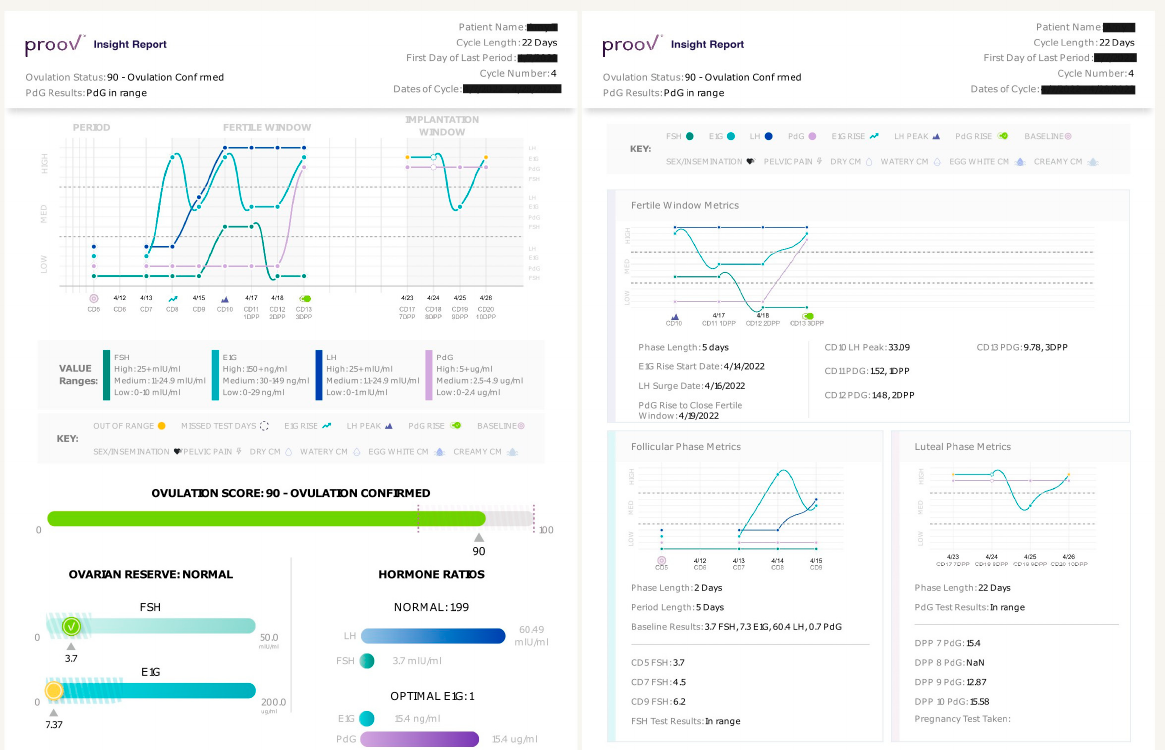
Figure 3. Proov Insight Report provides complete cycle mapping and guidance to patients and providers. The Proov Insight App generates a report on the final day of testing explaining hormone levels, providing an Ovulation Score, and summarizing overall hormone trends. The report also provides guidance on what the results mean and what to do next for those trying to